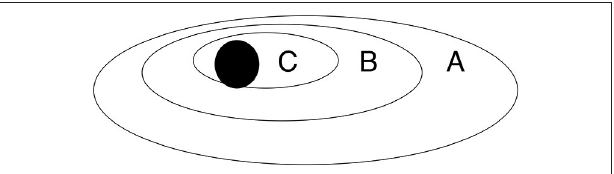
costs were dependent variables. The coefficient β means that for every unit change of PRISM score, PICU cost will change by β units. Statistical analyses were performed using SPSS 22.0 for Windows (SPSS Inc., Chicago, IL, USA).